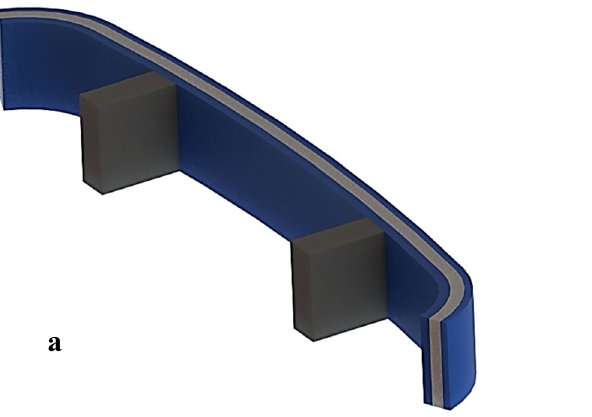
Figure 15. An application where tested samples of ATA may be used. ( a ) Car front bumper assembled view, and ( b ) exploded view (views taken from Solidworks software tool).